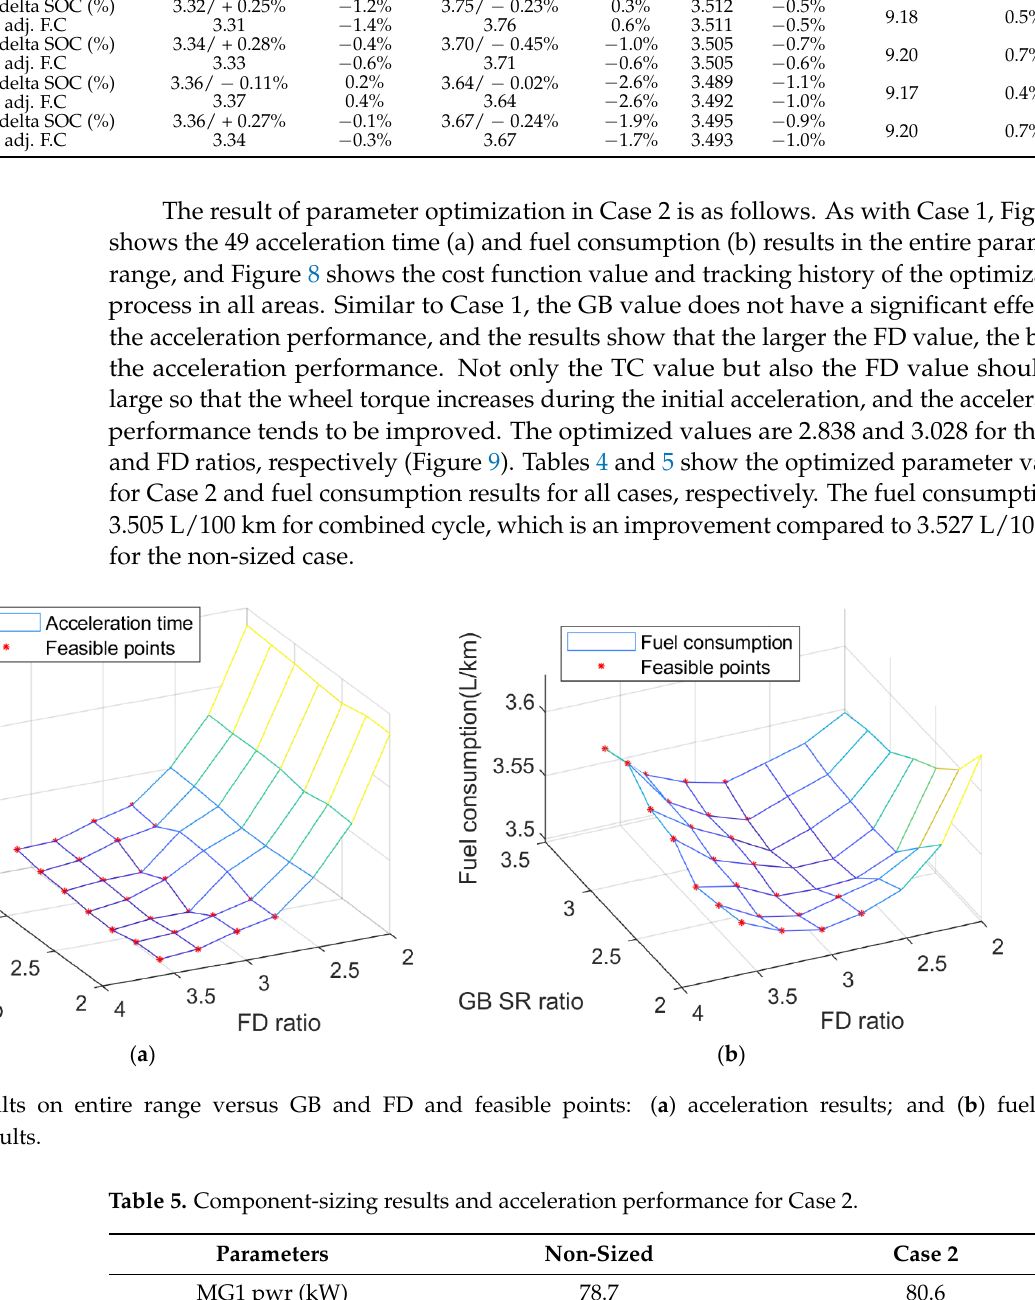
Table 4. Fuel consumption and acceleration time results for UDDS and HWFET and combined.